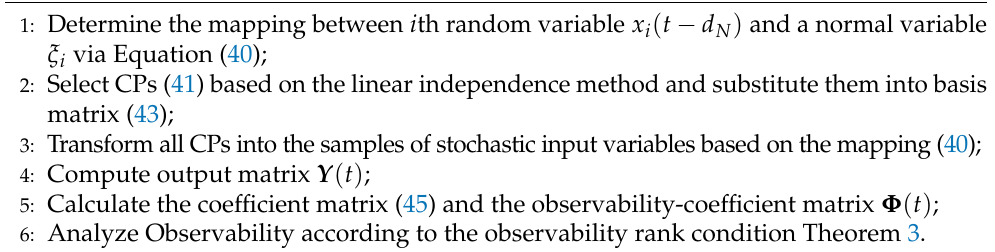
Algorithm 1 gPC-based Observability Analysis